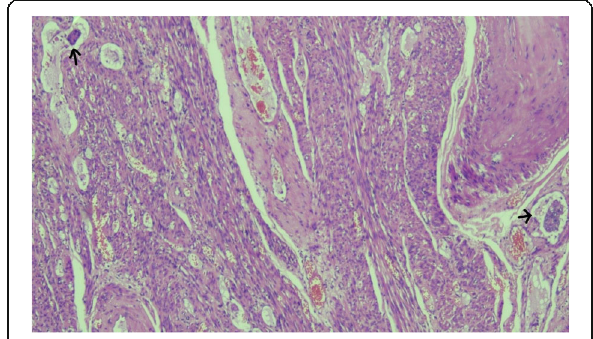
Fig. 2 Substantial lymphovascular invasion defined as ‘ diffuse or multifocal, ≥ 2 foci of LVI around the tumor, arrows (H & E X 10